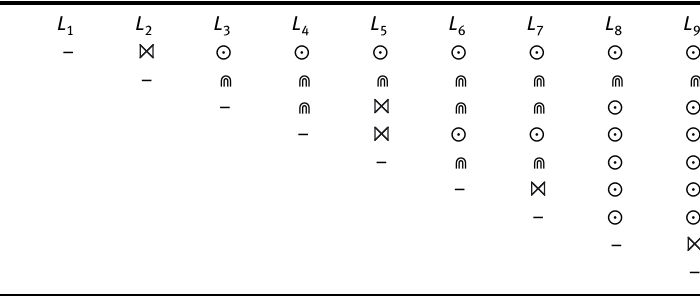
Table 5: Relation matrix of the shadow, illustrated in Figure 8, associated to